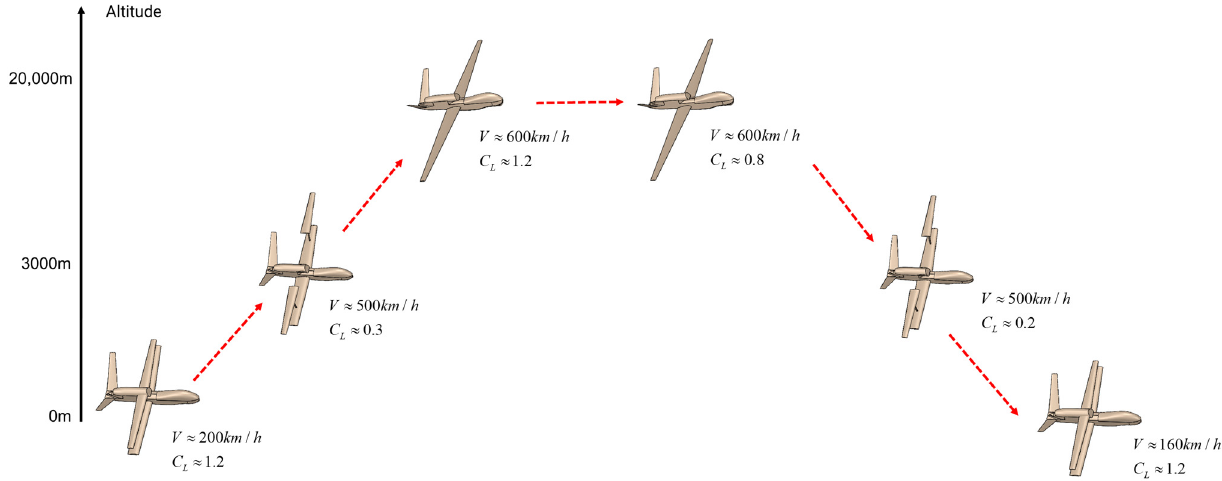
Figure 4. A typical airplane flight profile of the mono-biplane aerodynamics-driven morphing air- craft.